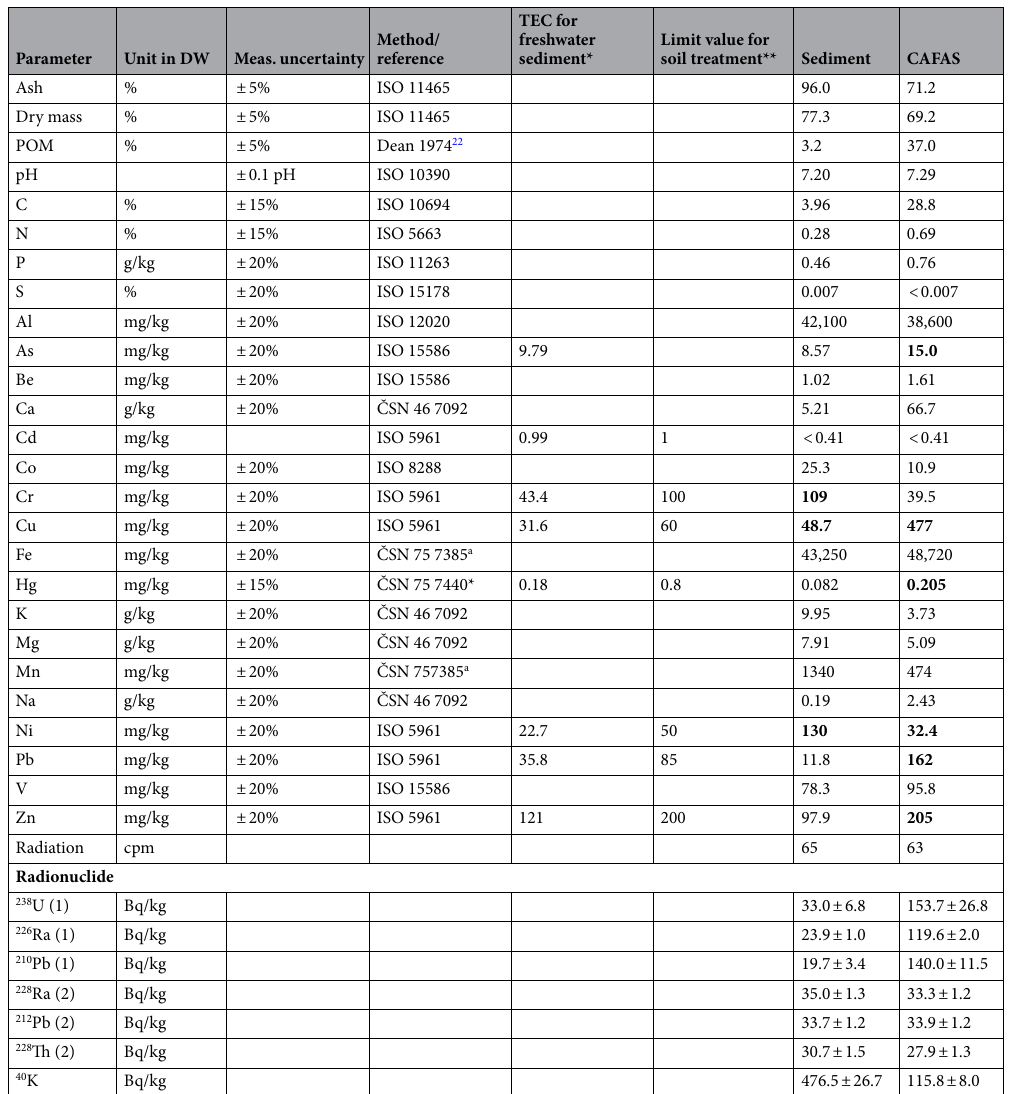
Table 1. Physico-chemical and radioactivity analyses of cave sediment and CAFAS from Divaška jama. The stated measurement uncertainty is the product of the standard measurement uncertainty and the expansion coefficient k = 2, which corresponds approximately to 95% coverage probability for normal distribution. Values shown in bold are those that exceed either threshold effect concentration (TEC) below which harmful effects are unlikely to be observed in freshwater ecosystems (MacDonald et al. 23 ) (*) and/or limit values for heavy metals in soil set by Decree on the management of sewage sludge from urban waste water treatment plants, Uradni list RS 2008, 62/08 (**). ČSN National standards of the Czech Republic; a Flame atomic absorption spectrometric method; *Determination of total mercury by thermal decomposition, amalgamation and atomic absorption spectrometry; (1) uranium decay chain, (2) thorium decay chain.